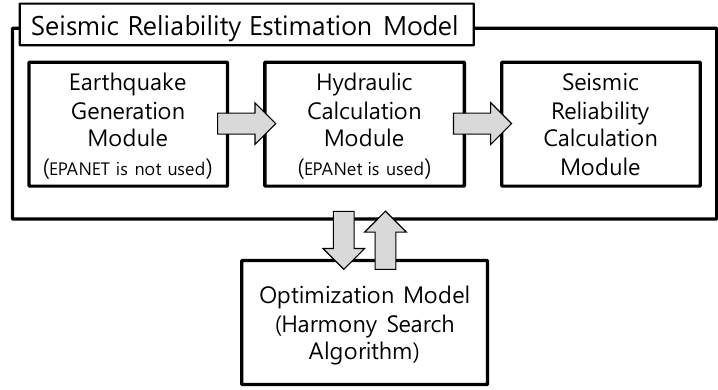
Figure 1. Flowchart of the proposed water distribution system (WDS) optimal design model.